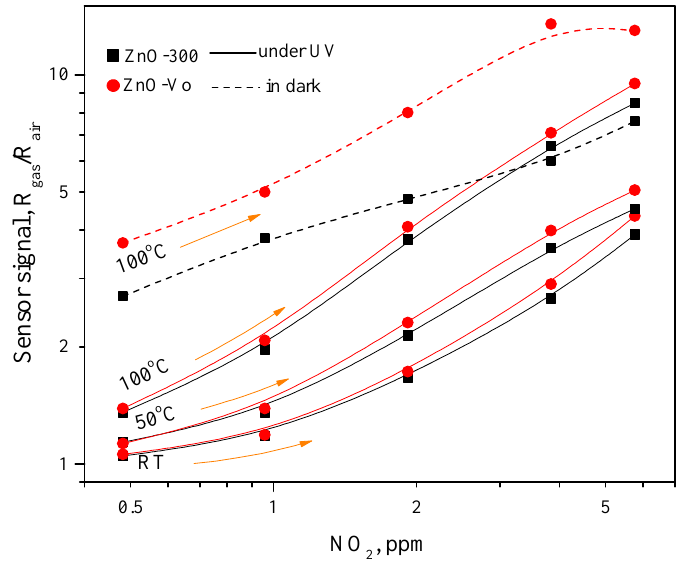
Figure 12. The concentration dependence of the sensor signal to NO 2 for ZnO-300 (rounds) and ZnO-V O (squares) sensors, measured under UV irradiation at temperatures of 30 ◦ C, 50 ◦ C, and 100 ◦ C (solid lines) and under dark conditions at 100 ◦ C (dashed